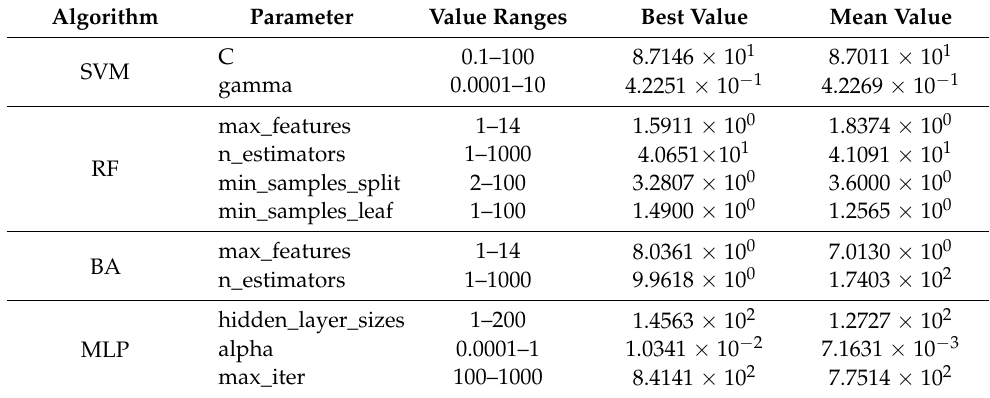
Table 1. Optimization parameter of models using BES.